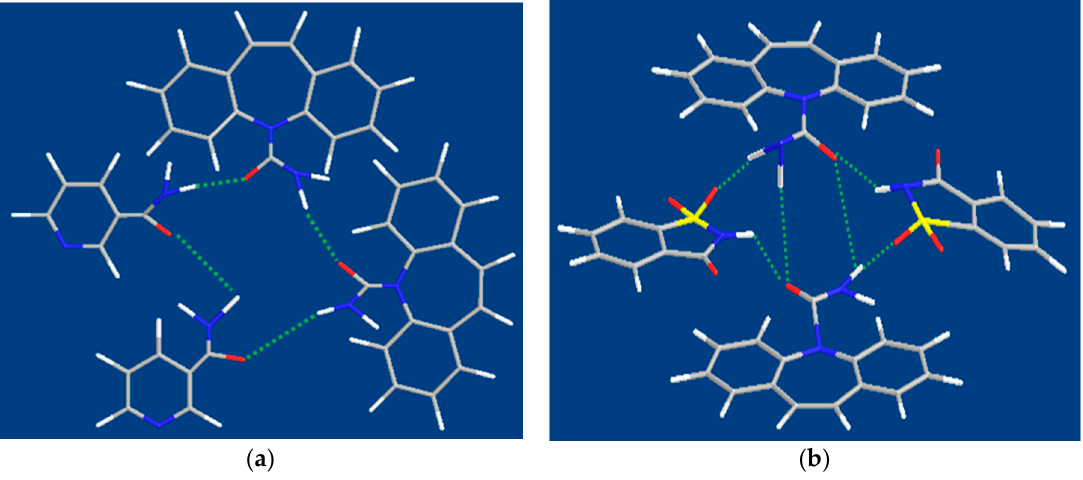
Figure 8. Illustration of the interaction between CBZ and coformer in cocrystal. ( a ) CBZ-NIC cocrystal ( b ) CBZ-SAC cocrsytal.